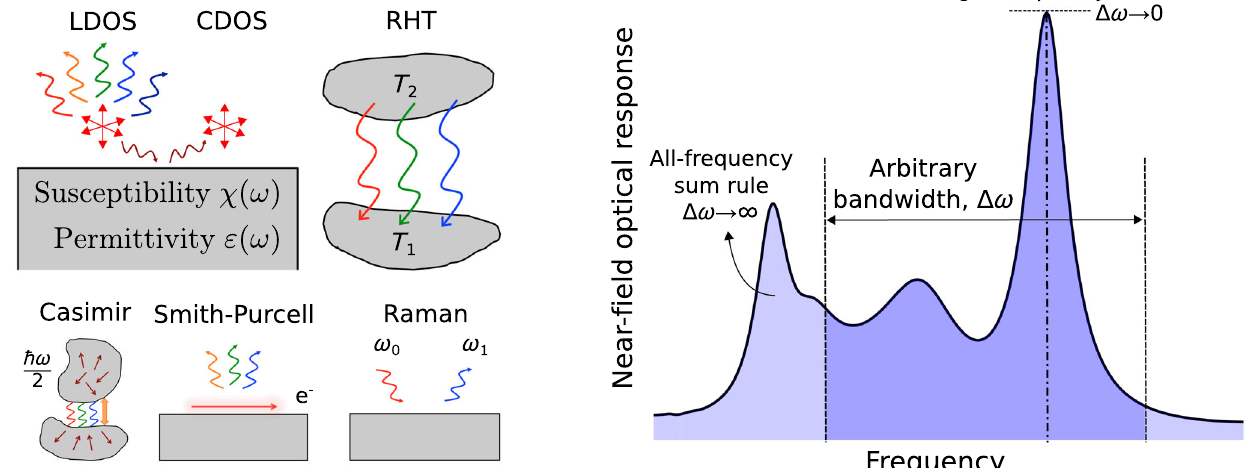
FIG. 1. Near-field optics exhibits phenomena ranging from spontaneous-emission enhancements through LDOS engineering, field- correlation phenomena as measured by CDOS, RHT, Casimir effects, Smith-Purcell radiation, and Raman scattering. Our theoretical framework, connecting causality principles with energy-conservation constraints, yields bounds over any arbitrary bandwidth. In the limit of zero bandwidth, we obtain recently discovered single-frequency bounds [36,37]; in the infinite-bandwidth limit, we arrive at a sum rule for integrated all-frequency